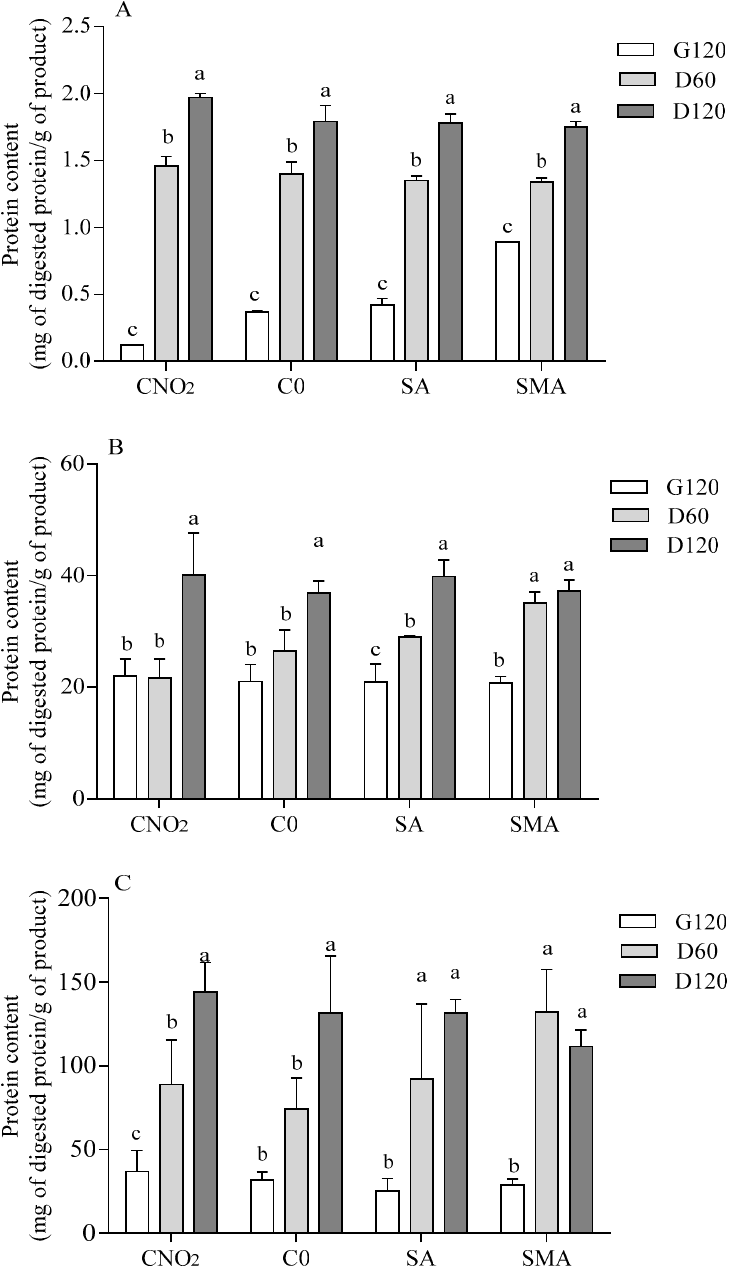
Figure 1. Time-course of protein hydrolysis in the different salami formulations. Protein content was assessed by OPA ( A ), Coomassie assay ( B ), and absorbance at 280 nm ( C ), and it is expressed as milligrams of protein digested/gram of product. Data are means ± SD of in vitro digestion of three independent samples analyzed in triplicate. Protein content is expressed as milligram of protein digested/gram of product. Statistical analysis was by one-way ANOVA (always p < 0.05) with Tukey’s post-hoc test comparing each salami formulation at the three digestion time points (different letters indicate statistical significance). G120: end of gastric phase; D60: 60 min of duodenal phase; D120: end of duodenal phase; C-NO 2 : salami with sodium nitrite, potassium nitrate and with nitrate-reducing microbial starter cultures; C-0: salami containing neither nitrate-reducing microbial starter cultures nor additives (nitrite, polyphenols and ascorbate); SA: salami with nitrate-reducing microbial starter cultures and sodium ascorbate; SMA: salami with nitrate-reducing microbial starter cultures, sodium ascorbate and plant